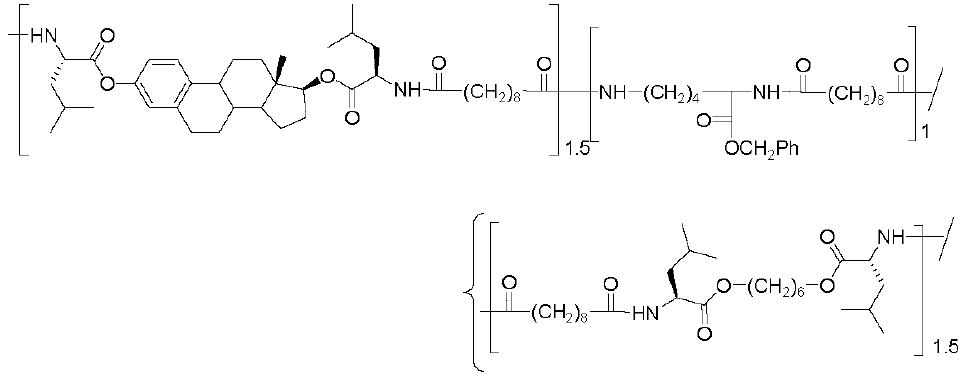
Figure 35. Drug-containing AABBP composed of 17- β -estradiol, 1,6-hexanediol, L -leucine, L -lysine benzyl ester, and sebacic acid.